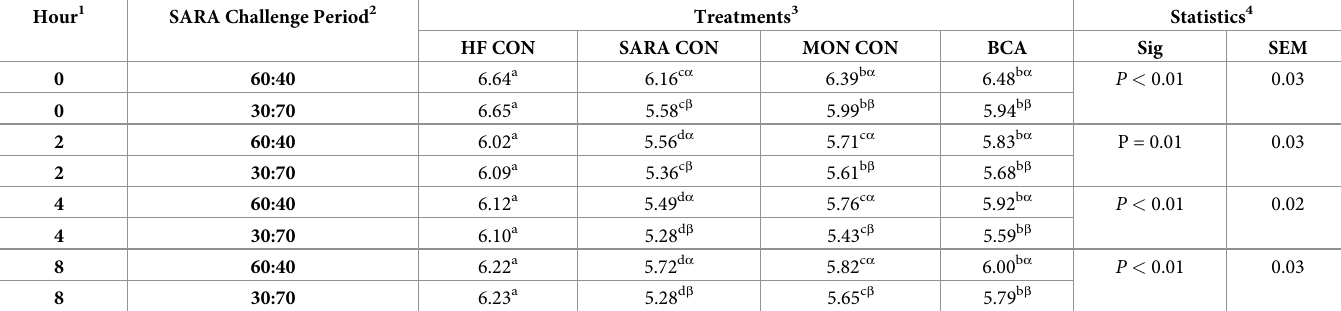
Table 3. Effect of biochanin A on rumen fluid pH during a 40% and 70% corn SARA challenge at 0 (pre-feeding), 2, 4, and 8 h (true means; n = 3).